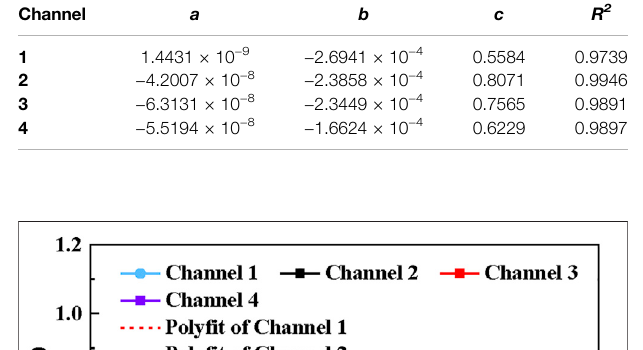
TABLE 3 | Parameters of polynomial fi tting for four sensing elements. Channel